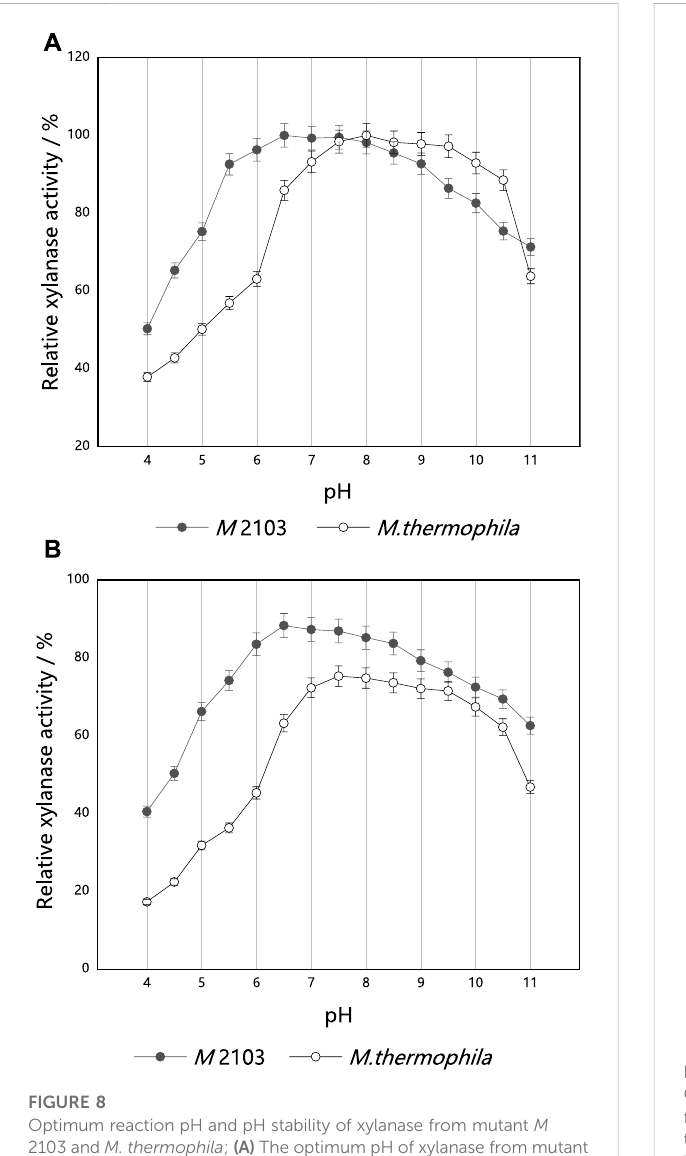
Optimum reaction pH and pH stability of xylanase from mutant M 2103 and M. thermophila ; (A) The optimum pH of xylanase from mutant M 2103 and M. thermophila ; (B) pH stability of xylanase from mutant M 2103 and M. thermophila . All experiments were carried out four times (biological duplicates and technical duplicates) and mean values presented with standard deviations.